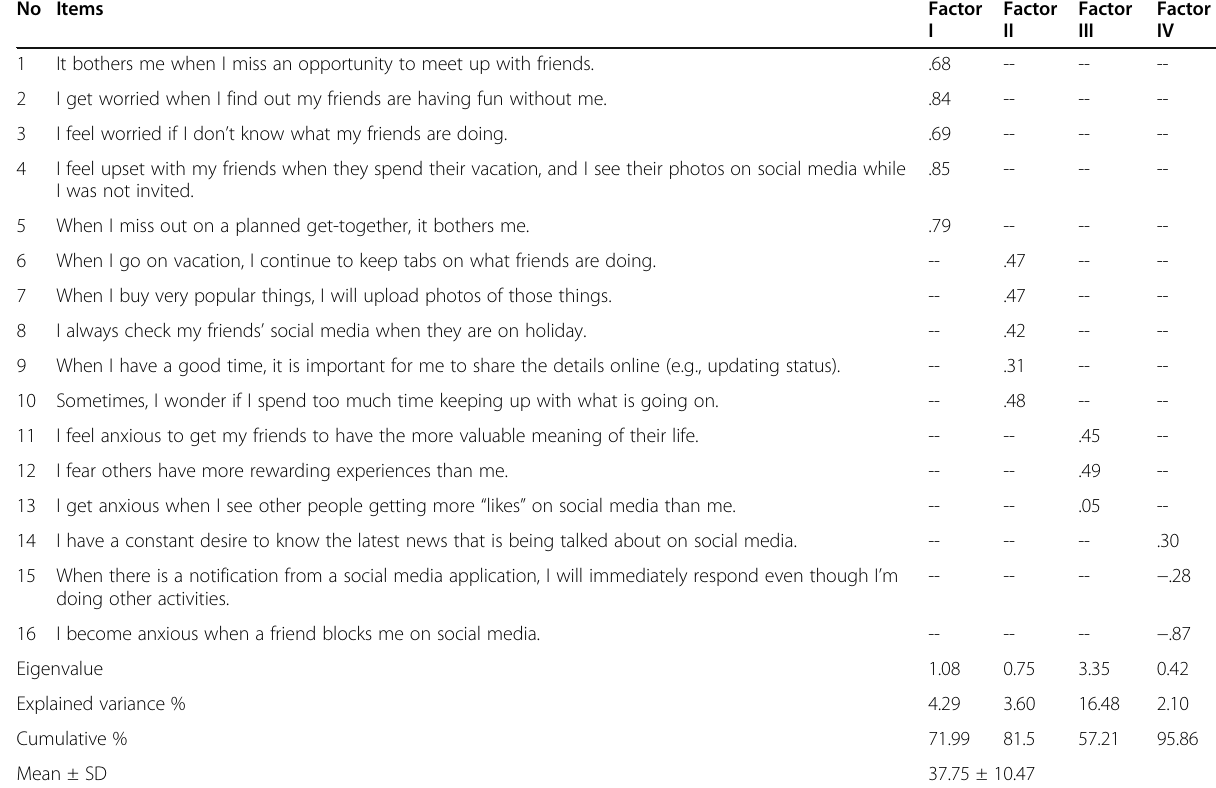
Table 5 Exploratory factor analysis: factor loadings for the FoMO, principal components, varimax rotation, eigenvalues, and percentage of explained variance (first version)